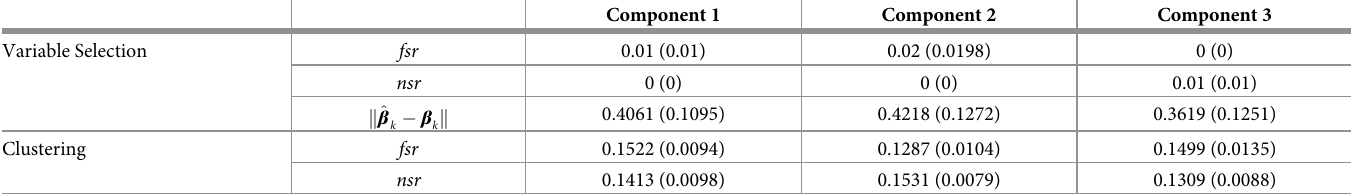
Table 1. Computational results of the ICC algorithm for the illustrative example, where fsr, nsr and k ^ β datasets with the standard deviation given in the parenthesis.